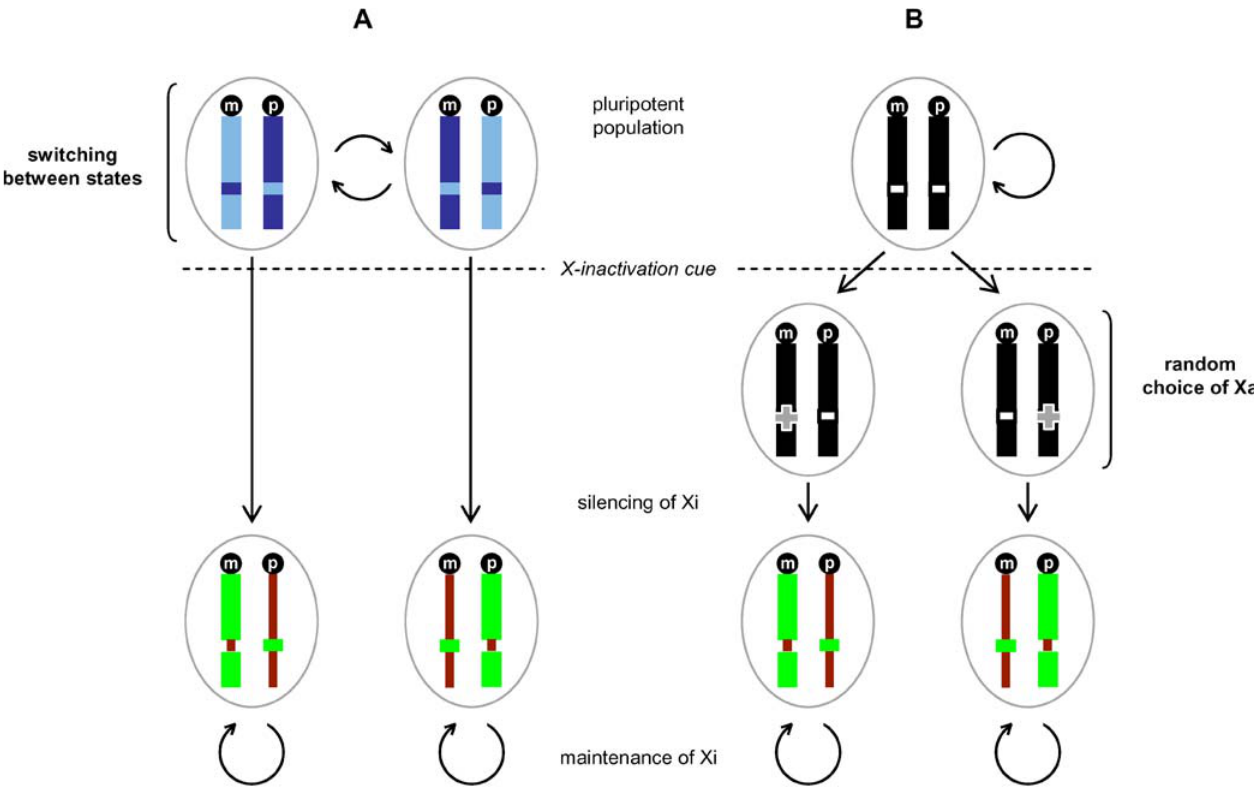
Figure 6. Models for Achieving Randomness in X-Inactivation (A) The data in the present study suggest a model in which the X chromosomes in pluripotent cells (m indicates maternal X chromosome, p indicates paternal X chromosome) coordinately switch between future Xa (light blue with dark blue Xic ) and future Xi (dark blue with light blue Xic ) states in cycling cells. The fates of the X chromosomes as the Xa (green with red Xic ) or the Xi (red with green Xic ) are determined by their states at the time that the cell receives the cue to initiate X-inactivation. (B) The prevailing model holds that the two X chromosomes in pluripotent cells (black, Xic indicated in white) are equivalent until the cue that initiates X-inactivation causes differential marking of the two X chromosomes (gray cross), thus designating the Xa and the Xi. DOI: